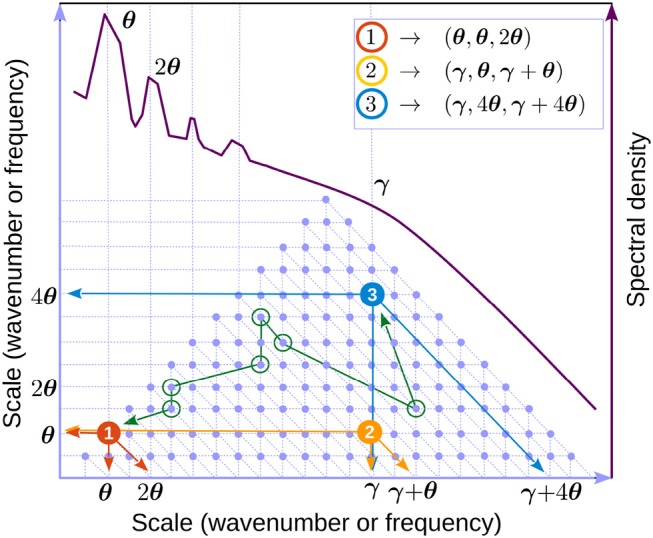
Discrete representation of interacting triads (Equation 8). The underlying grid geometry is the same as for the bispectral representation (see section 2, and also Figure 1). Because k and f are interchangeable, we refer to either as “scale”. Light blue dots represent triads. The axes represent scale 1 and 2 in the triad (e.g., k1 and k2 in Equation 10). The third interacting mode (k in Equation 10) may be found by as the intersection of the second diagonal passing through the triad with the horizontal axis (e.g., arrows in triad 1, red dot). One can easily check that the triangle of blue dots represents all possible triads for the scale interval shown (hence the triangular shape of the bispectrum). A schematic of a LFP spectral shape (dark red) is used to indicate possible locations for the theta (θ) and gamma (γ). Example of triads involving theta and gamma are identified by colored dots (compare with the annotations in Figure 5B). Green circles mark an example (arbitrarily-chosen) of a chain of triads connecting triads 1 and 3. The order of connection is marked with a green line. One can check that each pair of consecutive circles share one mode. All triads in the spectrum are connected by many such chains.